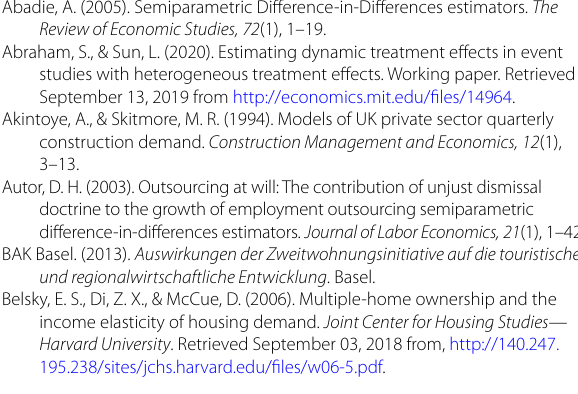
Abbreviations ARE: Federal Office for Spatial Development; DiD: Difference-in-difference; FSO: Federal Statistical Office; MTMC: Mobility and Transport Microcensus; SPA: Spatial Planning Act; SECO: Swiss State Secretariat for Economic Affairs.